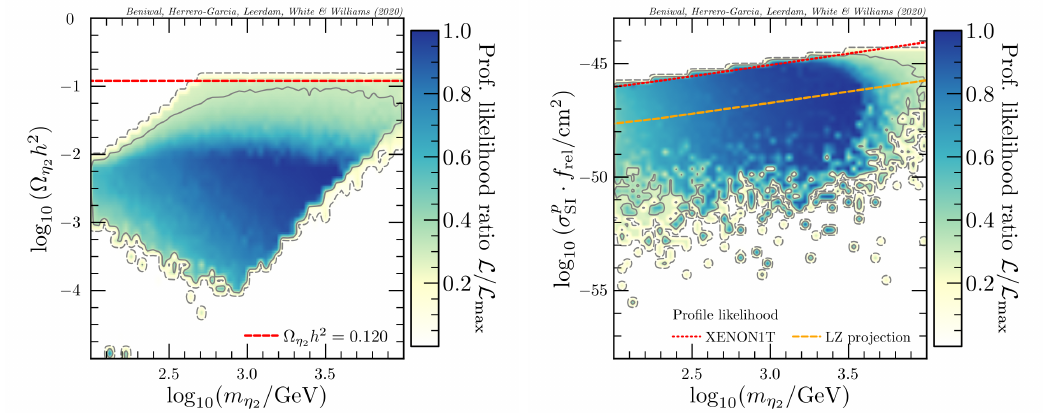
Figure 3 . Same as figure 2, but for the case of θ = π/ 2 , i.e., pure scalar doublet